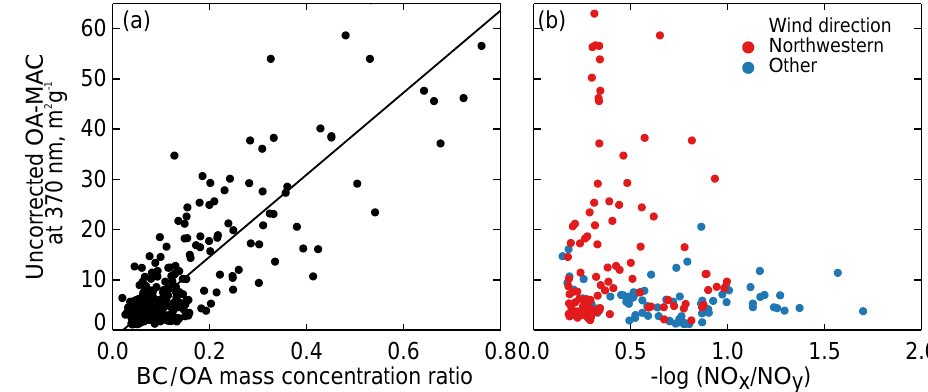
Figure 9. Measurements from the TCAP campaign in Cape Cod in February 2013. The relationship between uncorrected OA-MAC measured at 370nm and (a) the observed BC / OA ratio, as well as (b) the measured photochemical clock. All values are hourly means. The colors in (b) indicate different wind directions discussed in Sect.